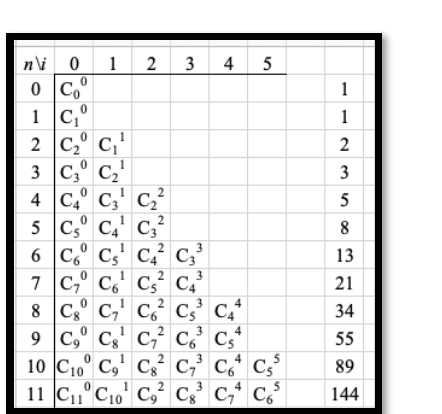
Figure 3. Factoring a Fibonacci-like polynomial.